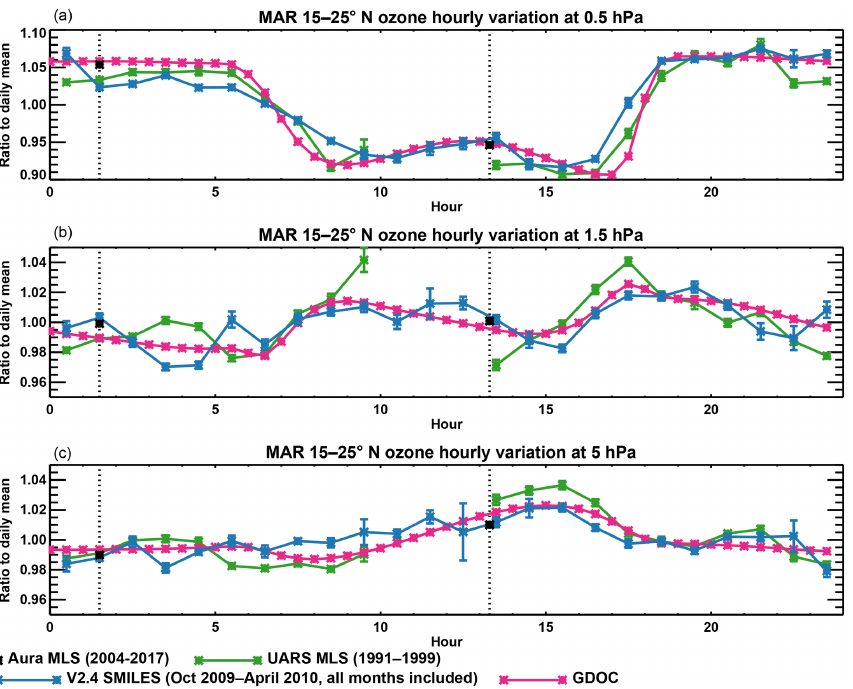
Figure 4. Diurnal variations as derived from SMILES (blue), UARS MLS (green) and Aura MLS (black symbols) compared to GDOC (red), plotted as a function of hour at three pressure levels: 0.5hPa (a) , 1.5hPa (b) and 5hPa (c) . Each product is normalized by its daily mean value, and the ratio is plotted. The black dotted lines indicate the two daily Aura MLS measurement times. UARS MLS means from 10:00 to 13:00LST are not computed due to limited sampling. The error bars are 2SEM. For the model and most satellite averages, this error is smaller than the symbol